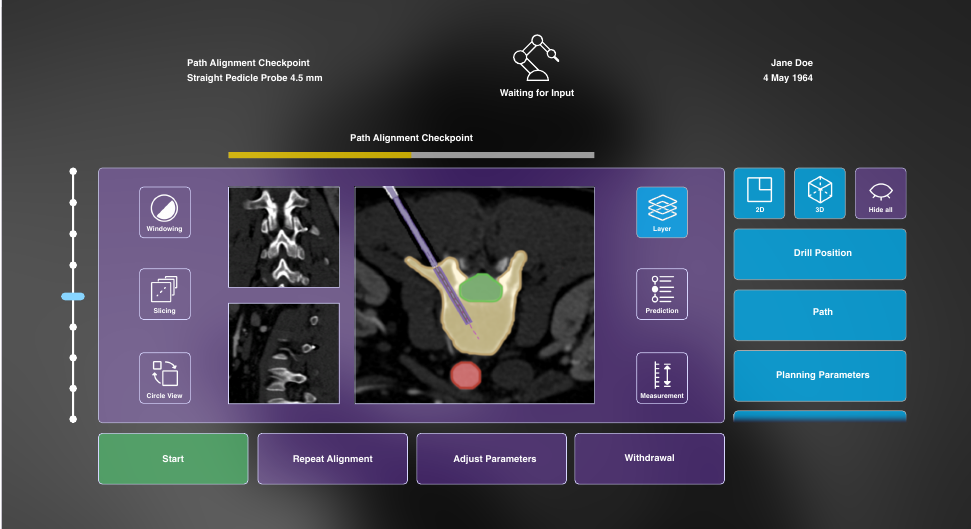
Figure 6. The developed AR interface during the path alignment checkpoint before initial vertebra drilling including a heads-up status bar ( top ) displaying general information and a dynamic GUI to enable system–user interaction ( bottom